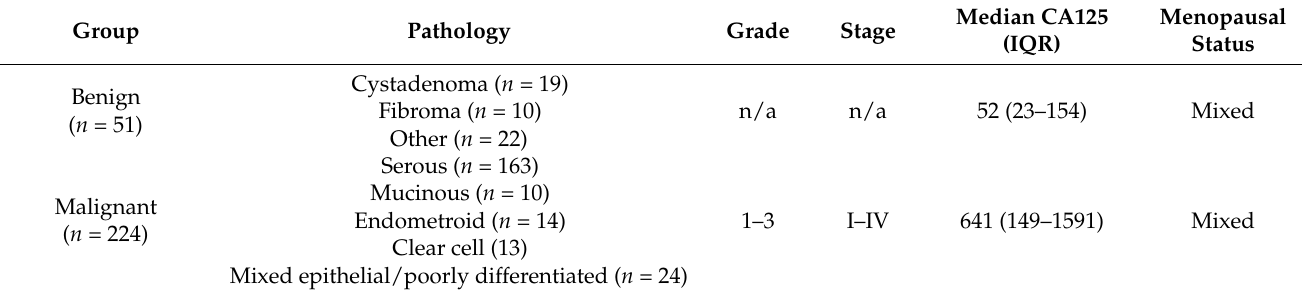
Table 2. Summary of patient samples (ascites, plasma, CVS) used for comparison of active CXCL10 ratios between benign and malignant samples *.